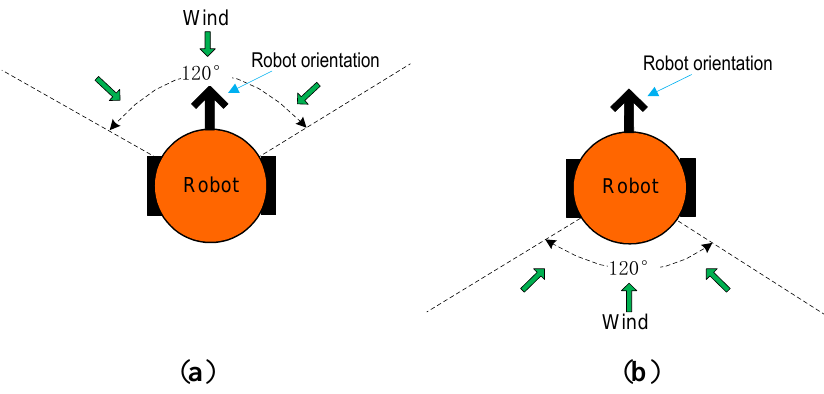
Figure 3. Definition of upwind and downwind directions based on the robot orientation and the sensed wind directions. The solid black arrow stands for the robot orientation, and the green arrows represent the wind directions. ( a ) Upwind; ( b )